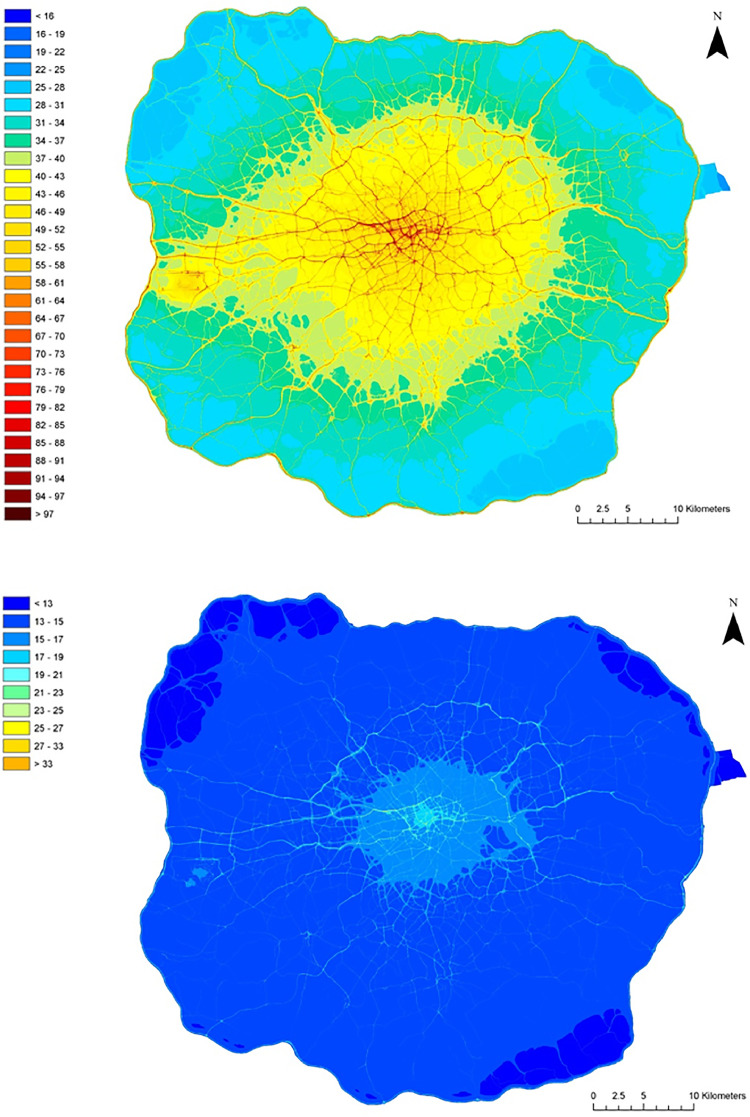
(a) Annual mean NO2 and PM2.5 for London in 2007. Figures display the annual mean NO2 (left) and PM2.5 (right) concentrations in 2007 across London. Color scale indicates compliance with national standards, with yellow and above indicating non-compliance. (b) Annual mean NO2 and PM2.5 for the E-Risk sample in 2007. Graphs display the annual mean NO2 (left) and PM2.5 (right) concentration in 2007 by quartile (μg/m3) for the parts of London where the E-Risk participants were living during this year. The black lines denote the current EU legislated standard and WHO air quality guidelines (40 μg/m3 for NO2; 25 μg/m3 and 10 μg/m3 for PM2.5 respectively).